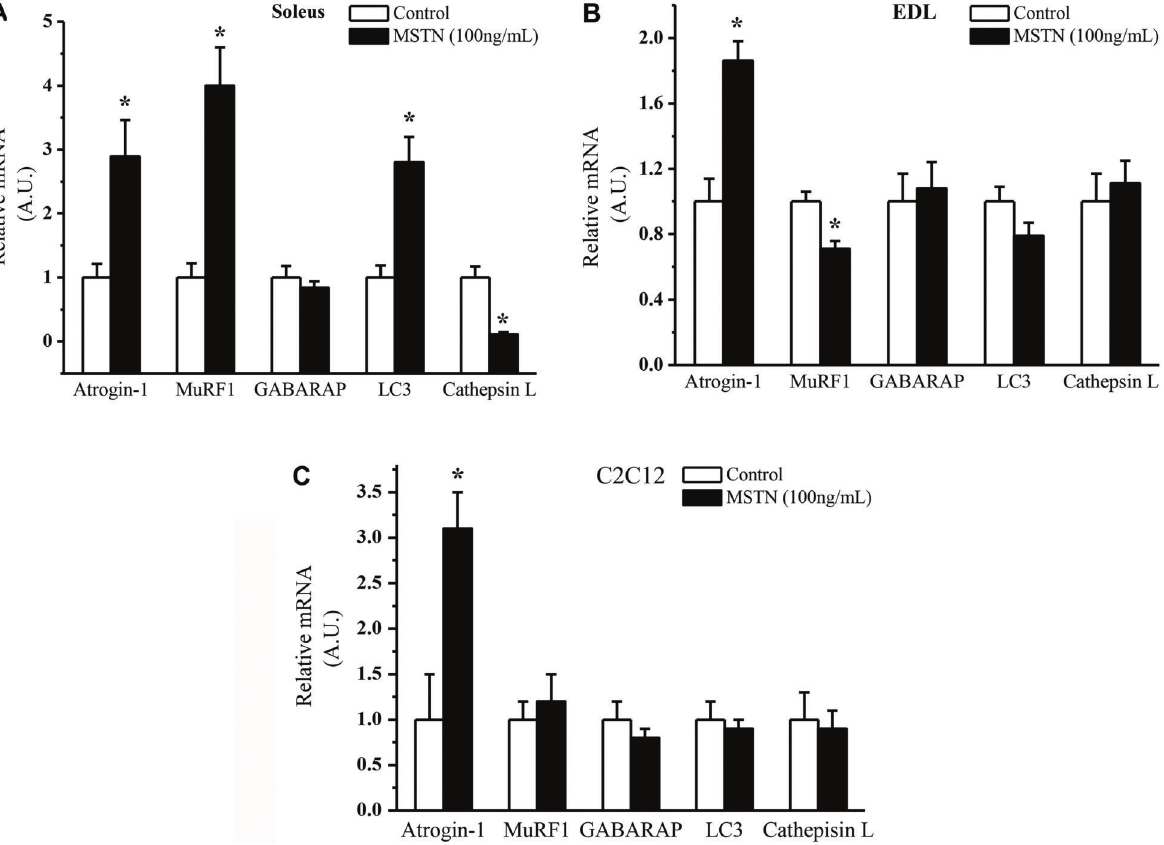
Figure 3. Gene expression of atrogin-1, MuRF1, GABARAP, LC3 and cathepsin L in A , soleus, B , extensor digitorum longus (EDL), and C , C2C12 cells incubated with myostatin (MSTN) for 4 h. Data are reported as the means ± SE of percentages (n=6). Controls were considered to be 100%. *P o 0.05 MSTN vs Control ( t -test). A.U.: arbitrary